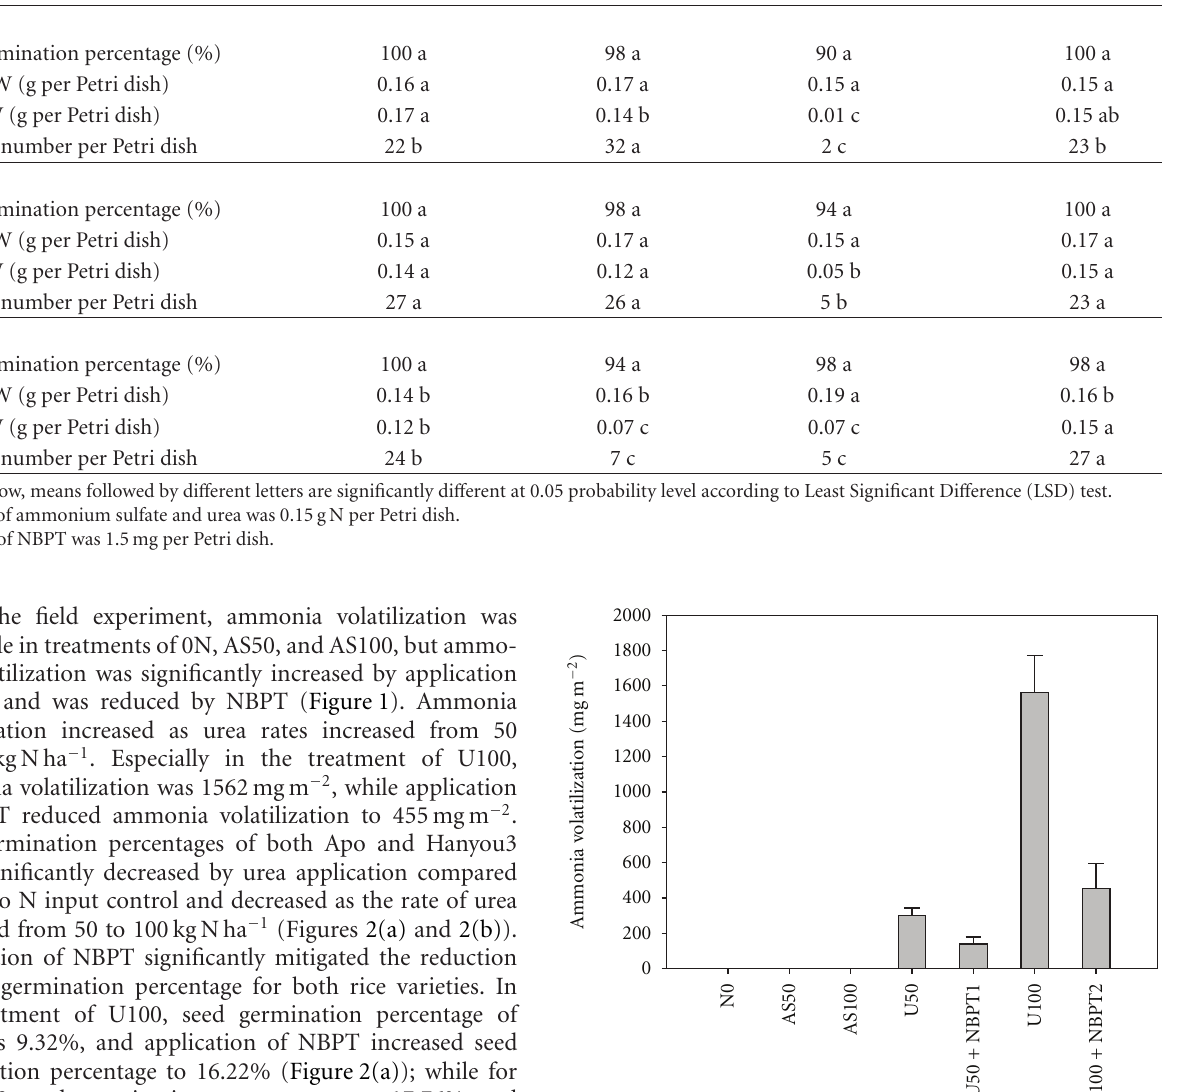
Table 3: Seed germination percentage, shoot fresh weight, root fresh weight, and root tip number of rice variety Apo grown in three di ff erent soils with ammonium sulfate, urea, and urea + NBPT in comparison with zero N input (control) in Petri dish incubation experiment 2. The presoaked seeds were not in contact with soil but exposed to ammonia gas volatilized from soils.